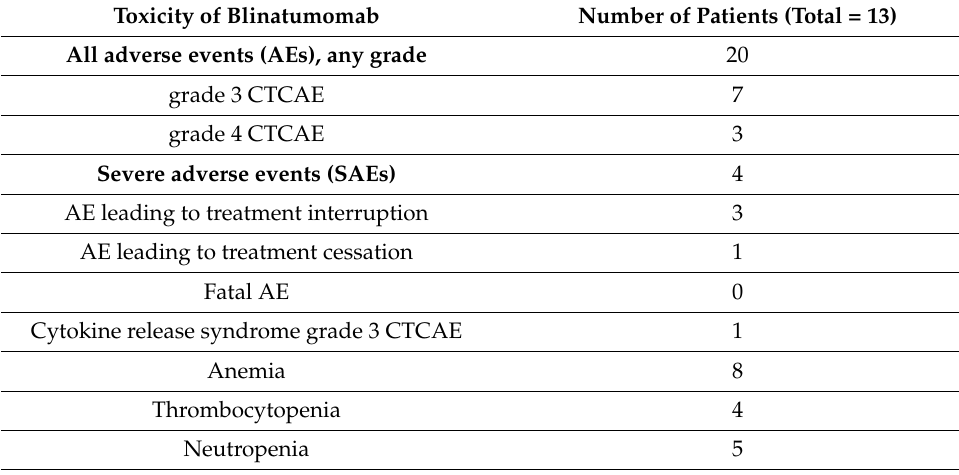
Table 2. Toxicity of blinatumomab therapy observed in study